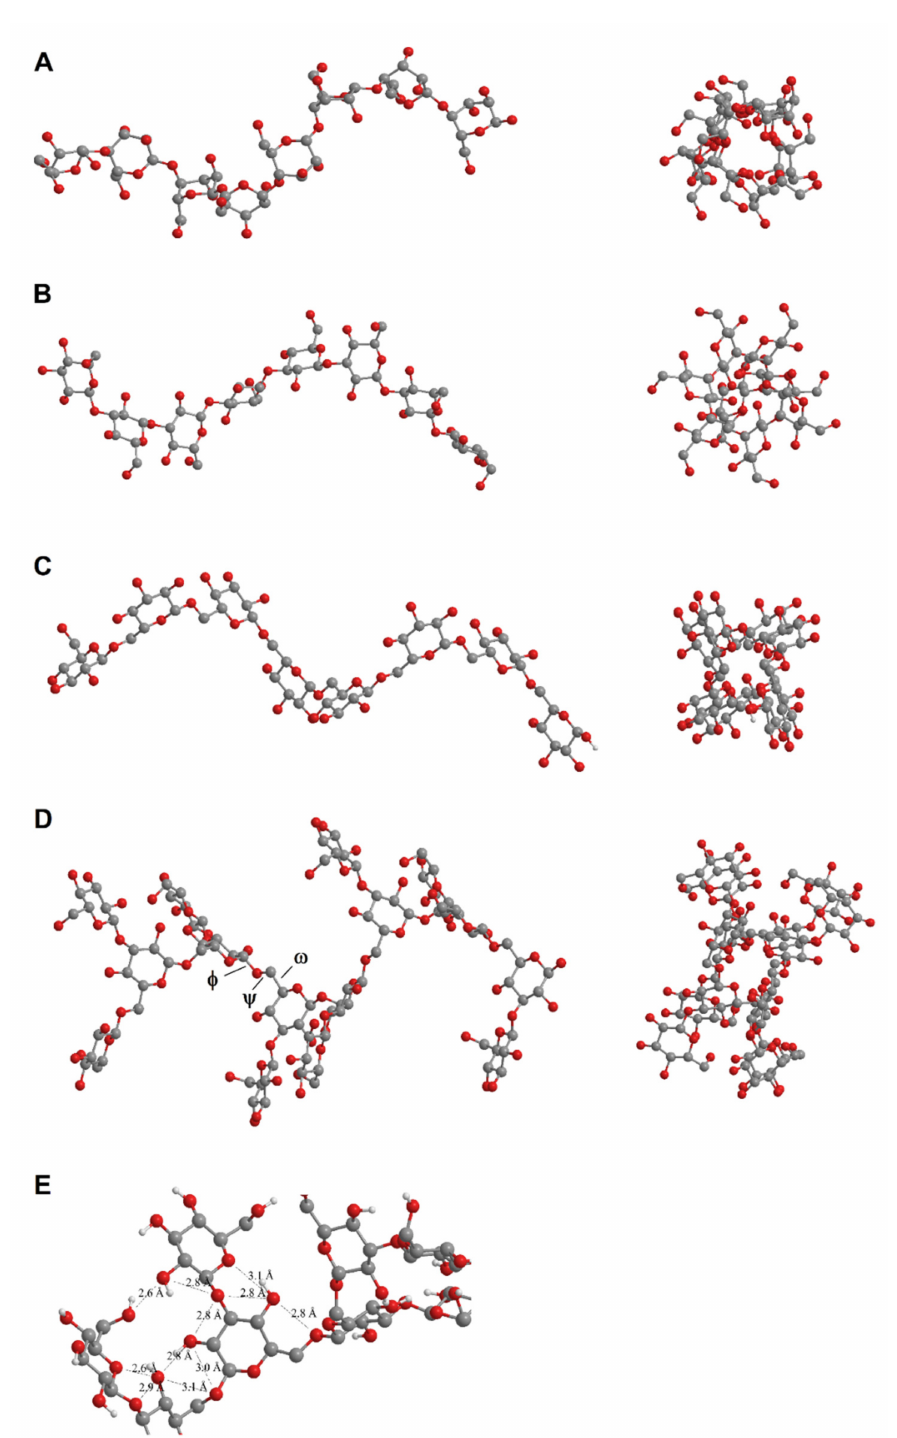
Figure 5. Structural models of the investigated polysaccharides; side view (left) and a view along the axis (right). ( A ) Polysaccharide A (1,4- α - D -glucan). ( B ) 1-3- β - D -glucan - component of B - C fraction. ( C ) 1-6- β - D -glucan-component of B - C fraction. ( D ) 1-3- β -branched 1-6- β - D -glucan - component of B - C fraction. ( E ) Distances (Å) between oxygen atoms, suggesting an opportunity for stabilization of the helical structure of 1-3- β -branched 1-6- β - D -glucan by hydrogen bonds. Created using the Chem3D Pro module of ChemOffice Professional 2017 (PerkinElmer). Energy minimization was performed using the MM2